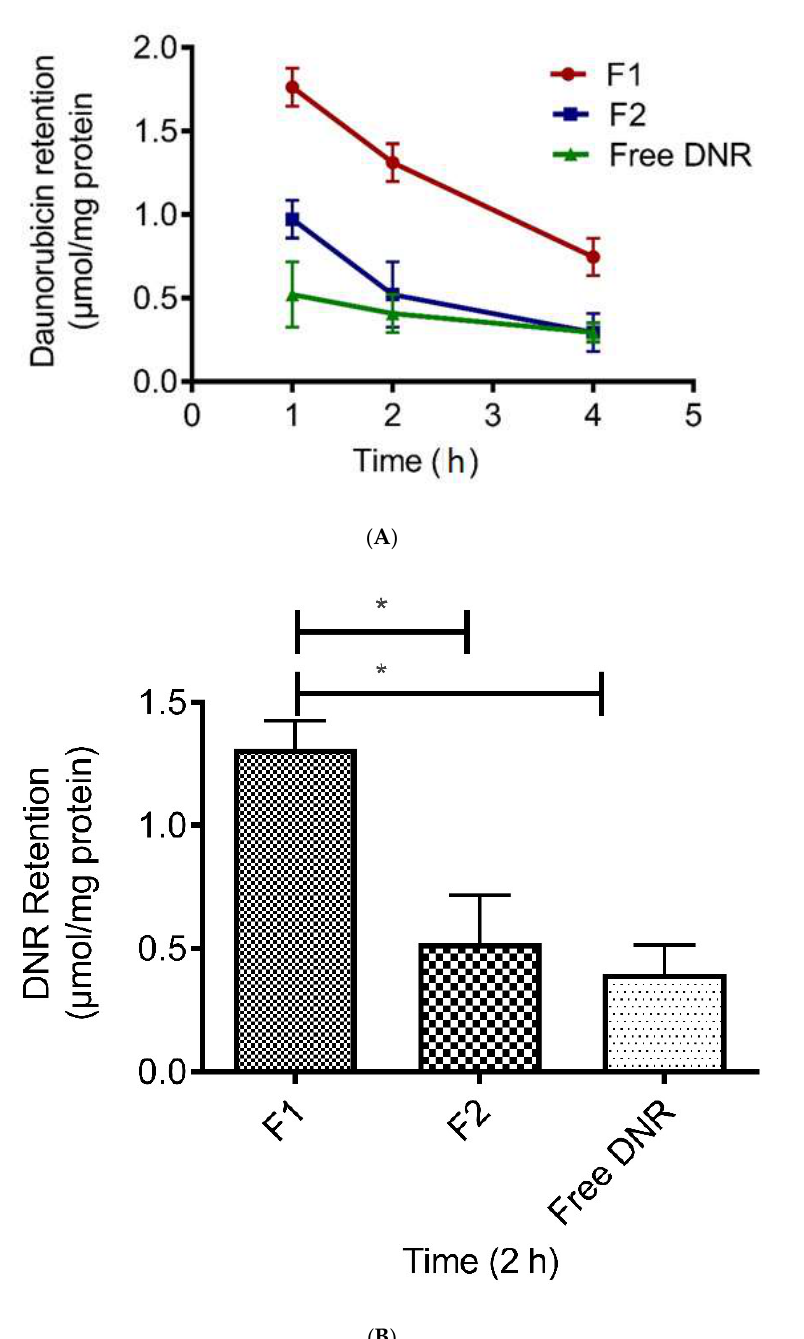
Figure 4. ( A ) Effect of pH-sensitive liposomes enriched with CL on the amount of DNR retained by B16-BL6 cancer cell lines. Values represent mean ± SD, n = 3. ( B ) The effect of pH-sensitive liposomes enriched with CL on the amount of DNR retained by B16-BL6 cancer cell lines. * Indicates p < 0.05. Values represent mean ± SD, n =